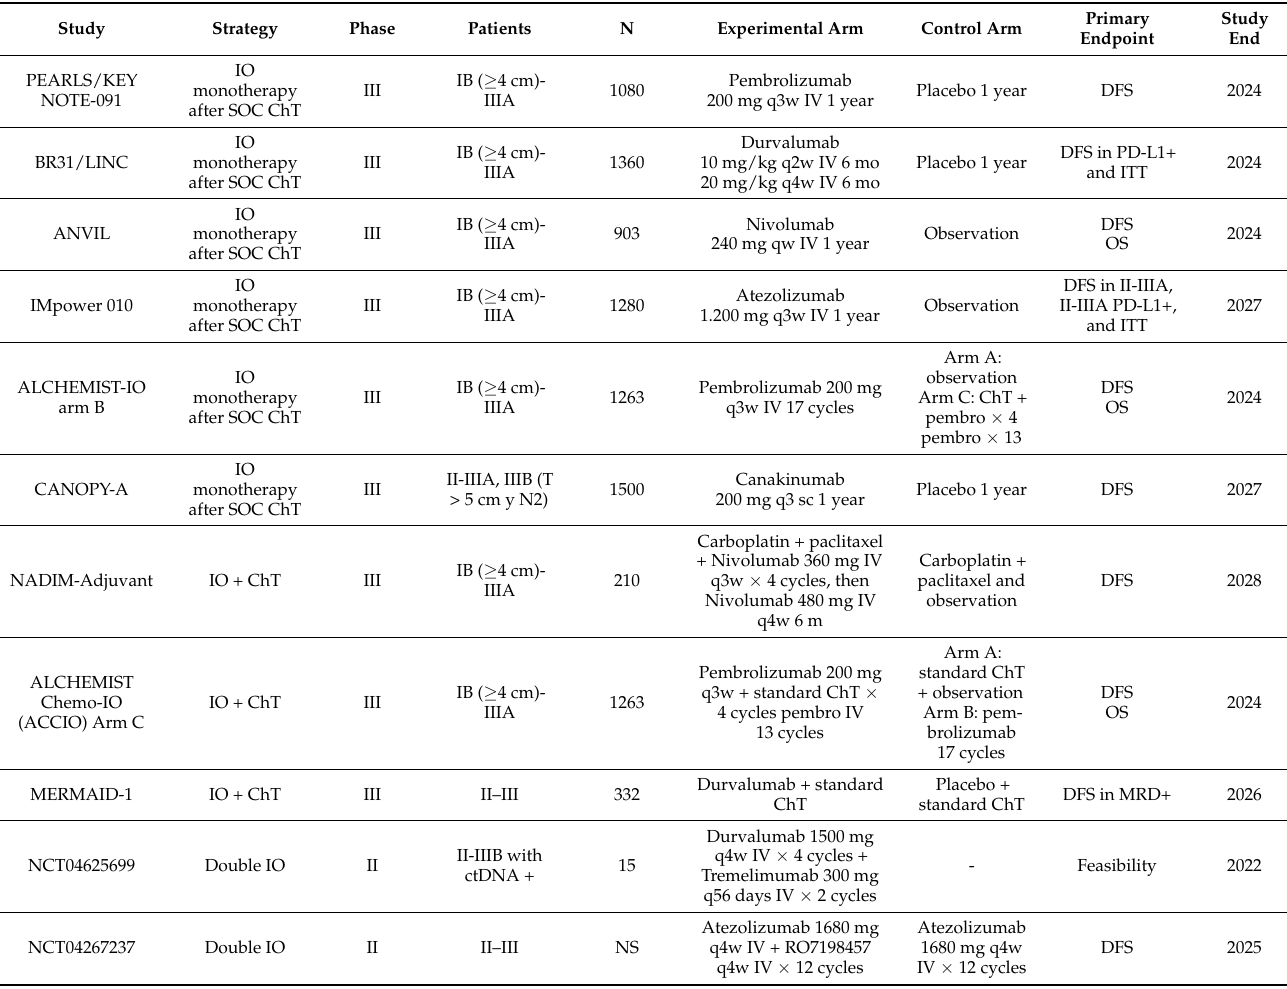
Table 1. Studies evaluating adjuvant immunotherapy in Stage III-N2